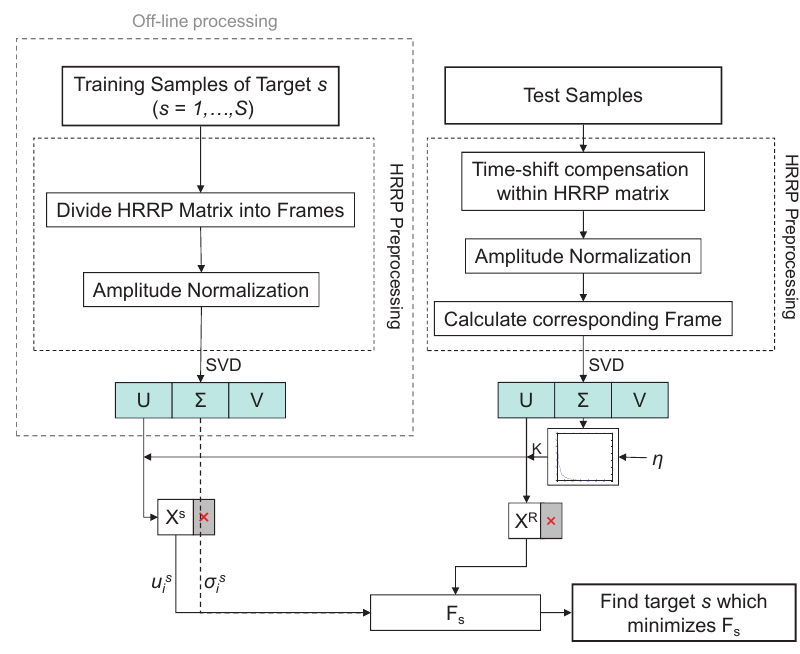
Figure 5. Flow chart of the proposed recognition